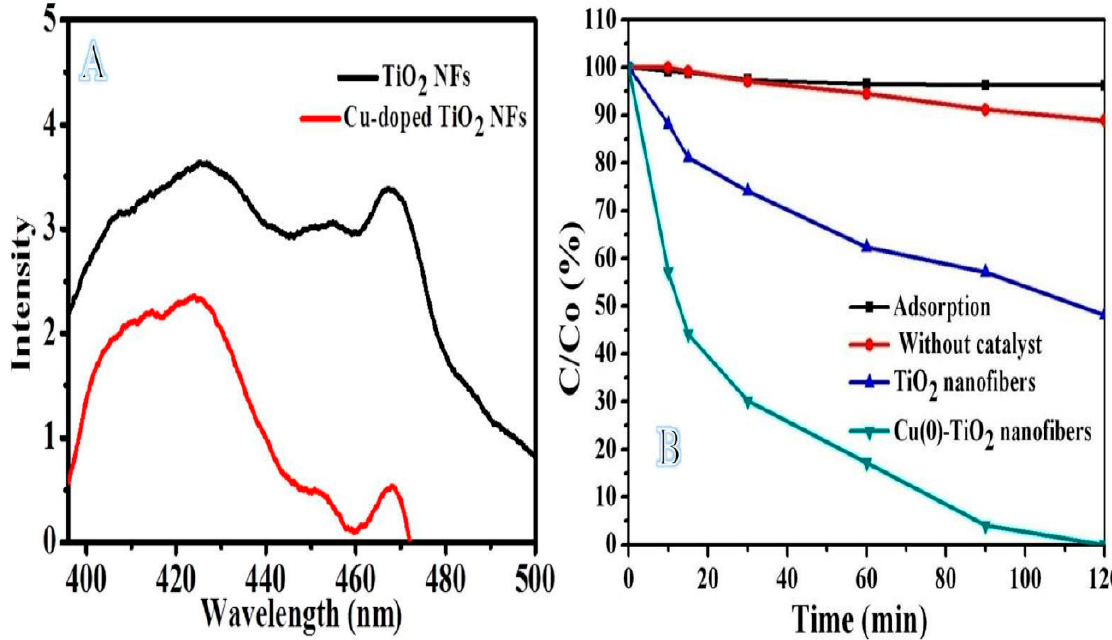
Figure 4. Photoluminescence spectrum of composite NFs and TiO 2 NFs ( A ) and photodegradation profiles of the MB under sunlight irradiation ( B ).